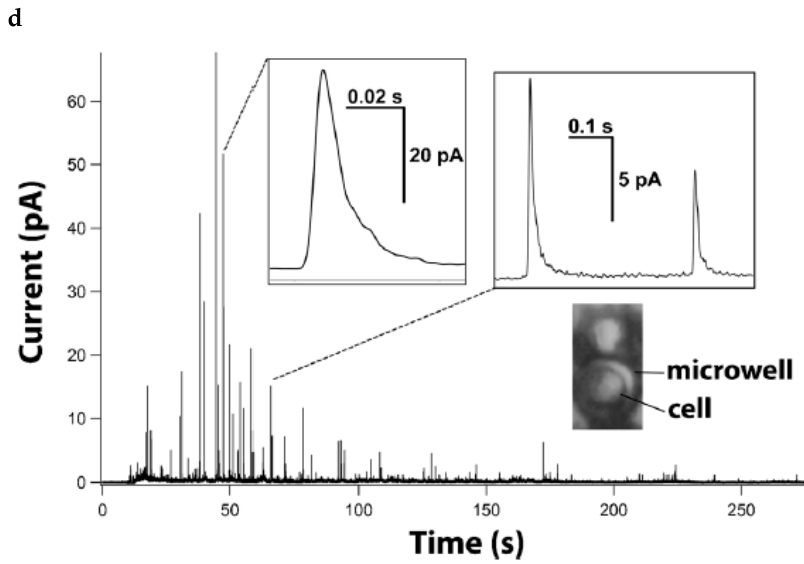
Figure 7. ( a ) Fabrication process of the microwells by photolithography; ( b ) side view of the microwell structure; ( c ) micrograph of a sensor array (300 × 500 µm); and ( d ) signal recorded for a unique live chromaffin cell settled down in a well, in direct contact with the electrode. Adapted from Huang et al. [14]. Copyright © 2017 Springer-Verlag GmbH.